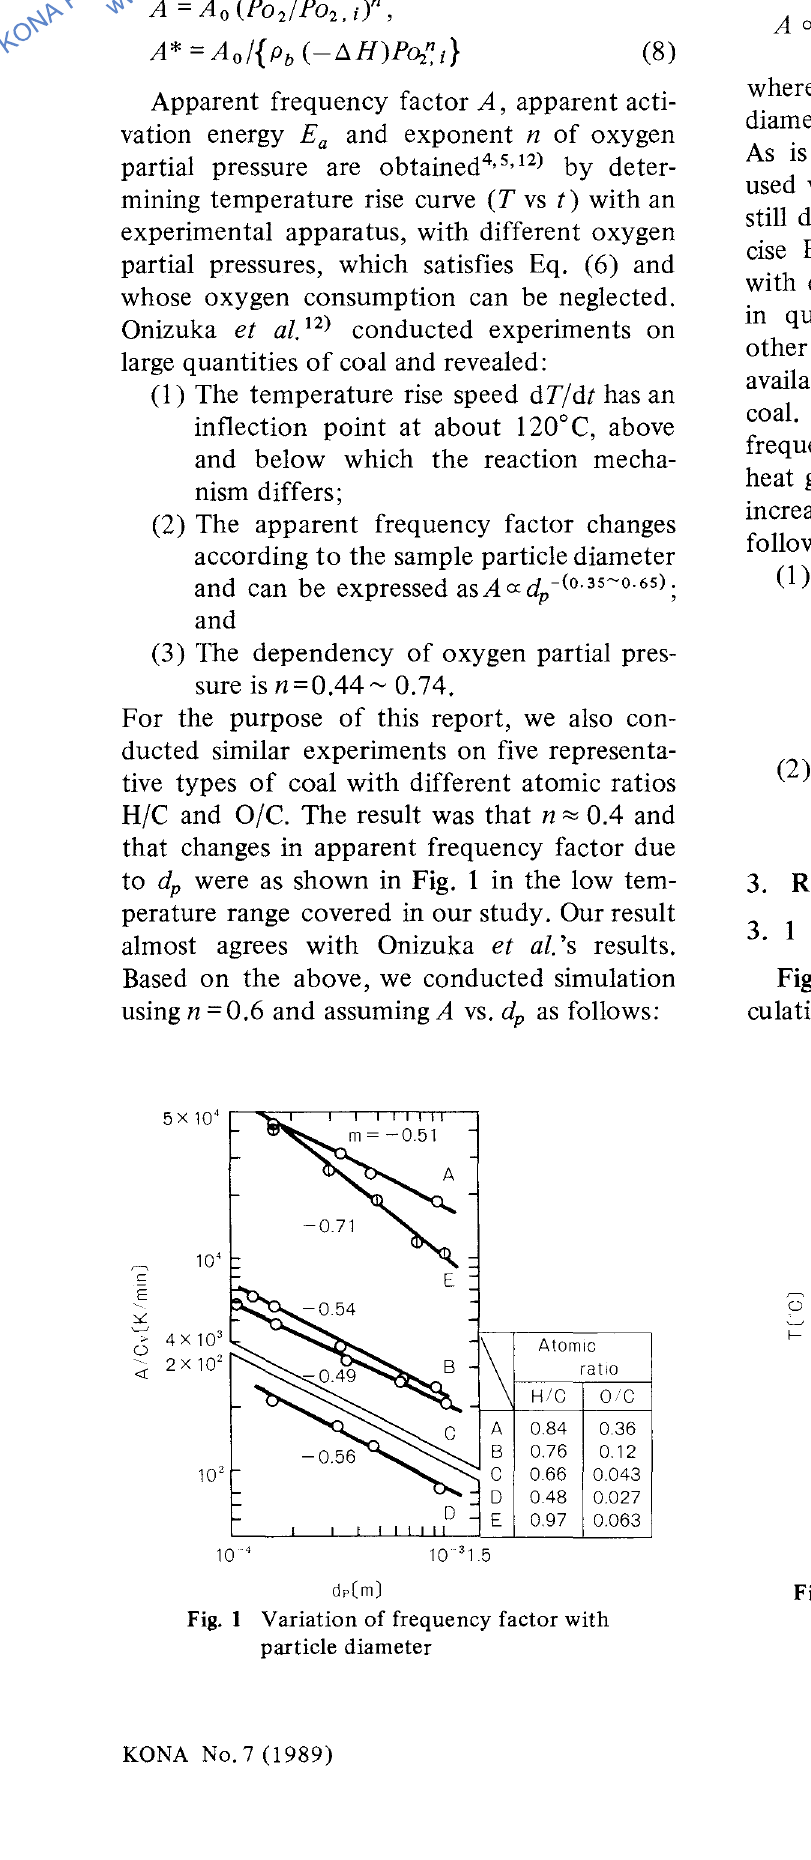
Fig. 1 Variation of frequency factor with particle diameter